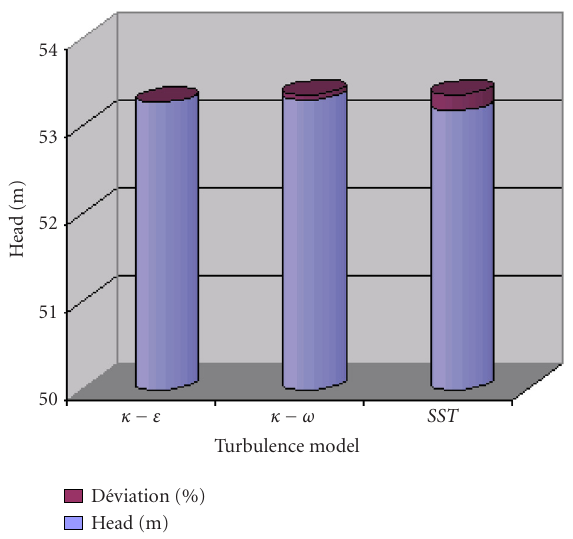
Figure 4: Influence of grid size on the meridional velocity at the leading edge of the blade: CFX-TASCflow code and impeller NS32.